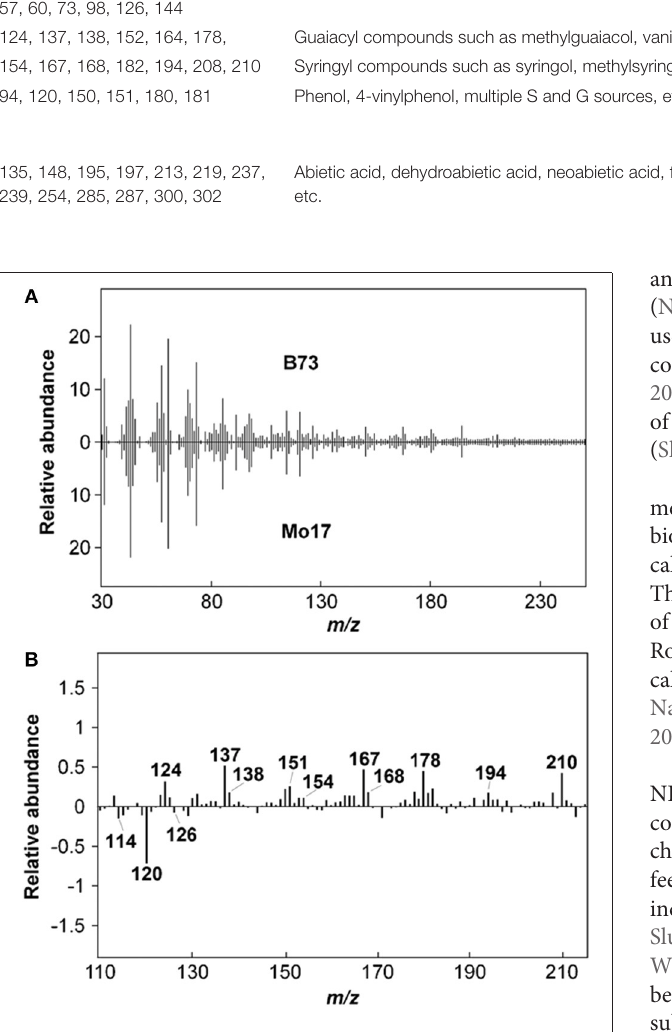
spectra that could potentially inform other useful properties of